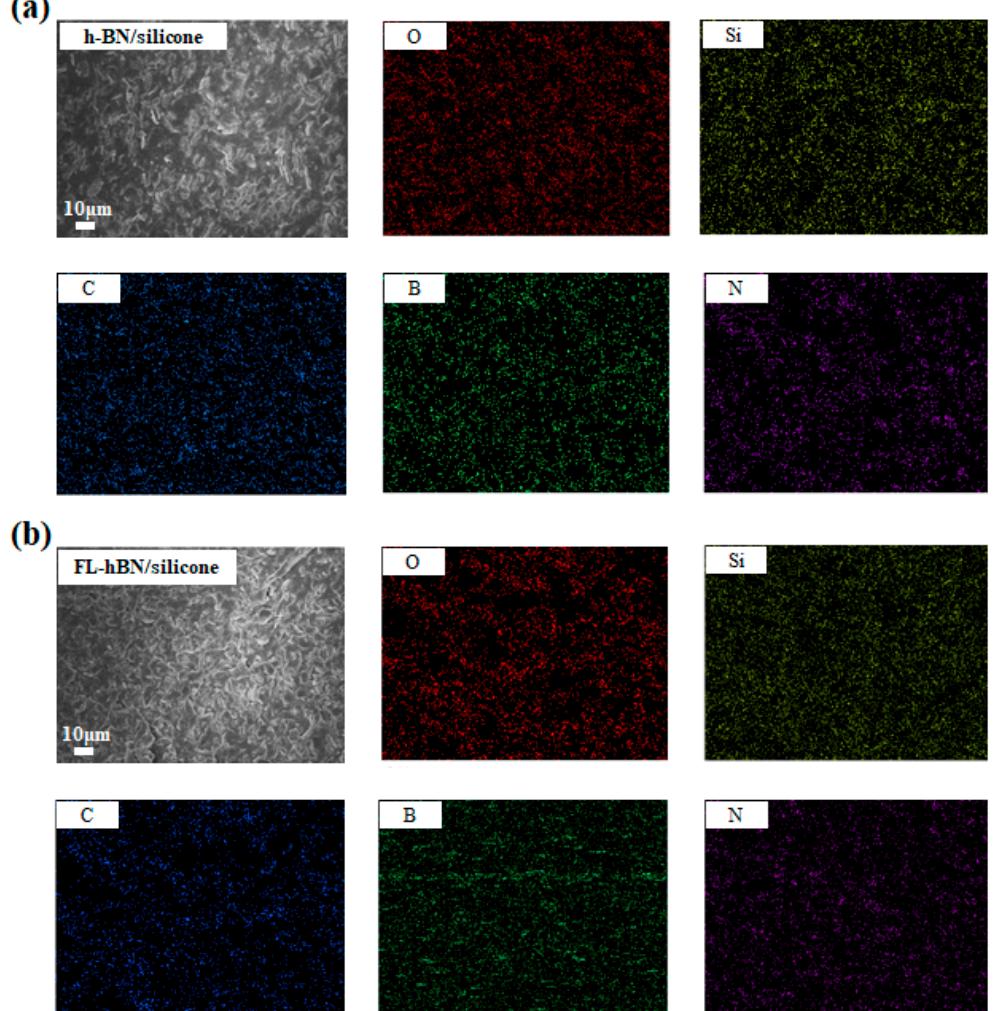
Figure 8. The Energy-dispersive X-ray spectroscopy (EDX) mapping of ( a ) h-BN/silicone (30 wt.%) and ( b ) FL-hBN/silicone (30 wt.%).